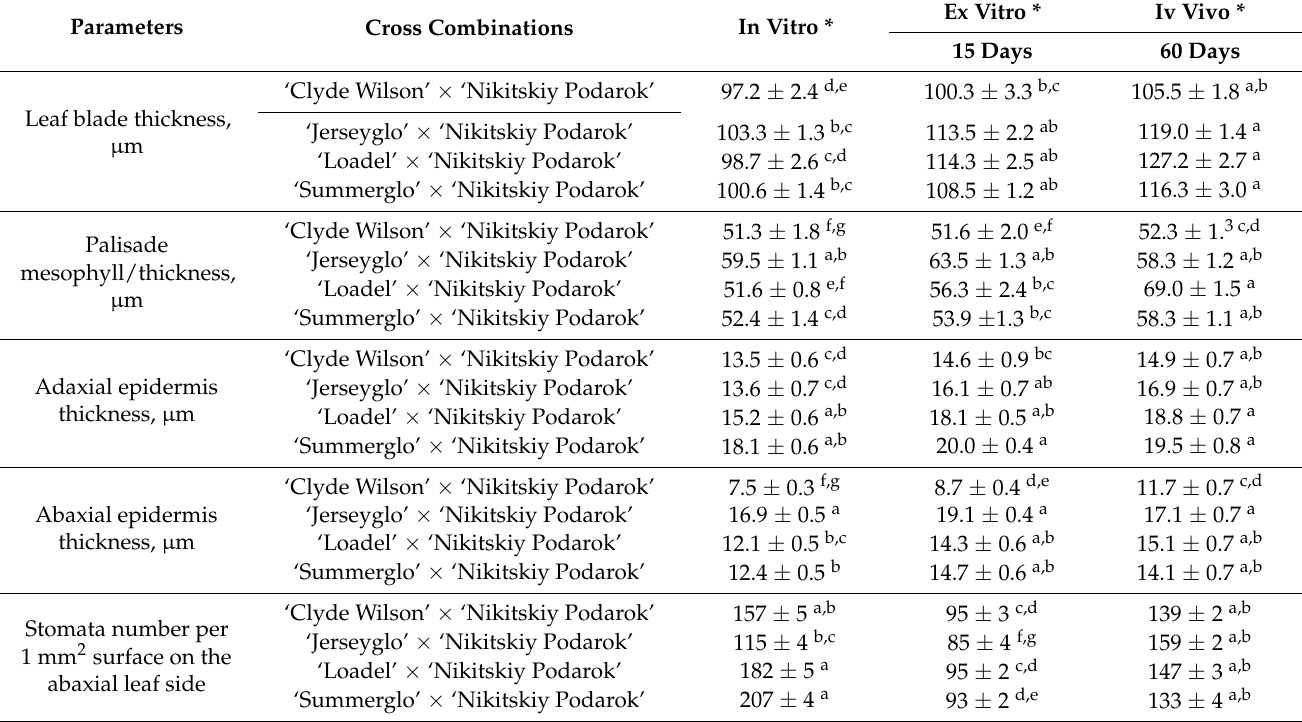
Table 4. Structural characteristics of leaves in peach hybrids under in vitro culture, and acclimatization of plantlets ex vitro and in